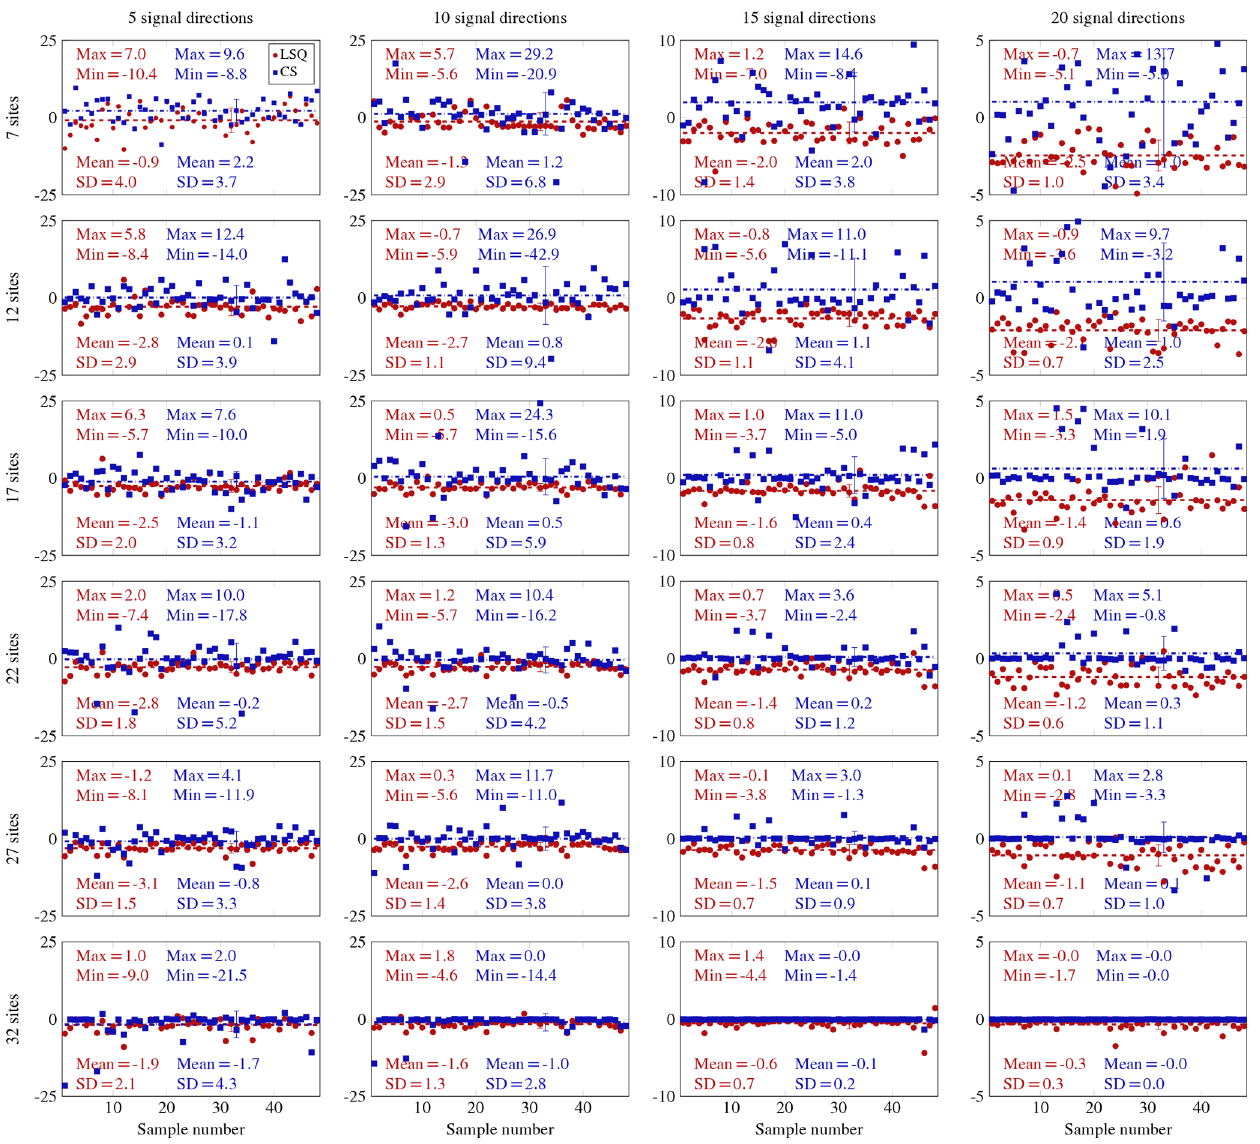
Figure 3. Absolute differences between estimated refractivity and the WRF refractivity in ppm for an exemplary voxel in the lower middle of the lowest voxel layer for the 48 samples of each investigated observing geometry setting. The two left columns use an ordinate ranging from − 25 to 25ppm, the third column plots the differences within the range − 10 to 10ppm, and the right column plots the differences within the range − 5 to 5ppm. The legend in the upper left subplot holds for all the subplots: red circles stand for the LSQ results, while blue squares represent the CS results. In each subplot, the minimum and maximum absolute differences in ppm of the LSQ or CS refractivity estimate with respect to the WRF input refractivities and the mean and the standard deviation over all samples are given in red and blue. Moreover, the mean and the standard deviation over all the samples are indicated for LSQ by a red dashed line, for CS by a blue dash-dotted line, and in the corresponding colors by error